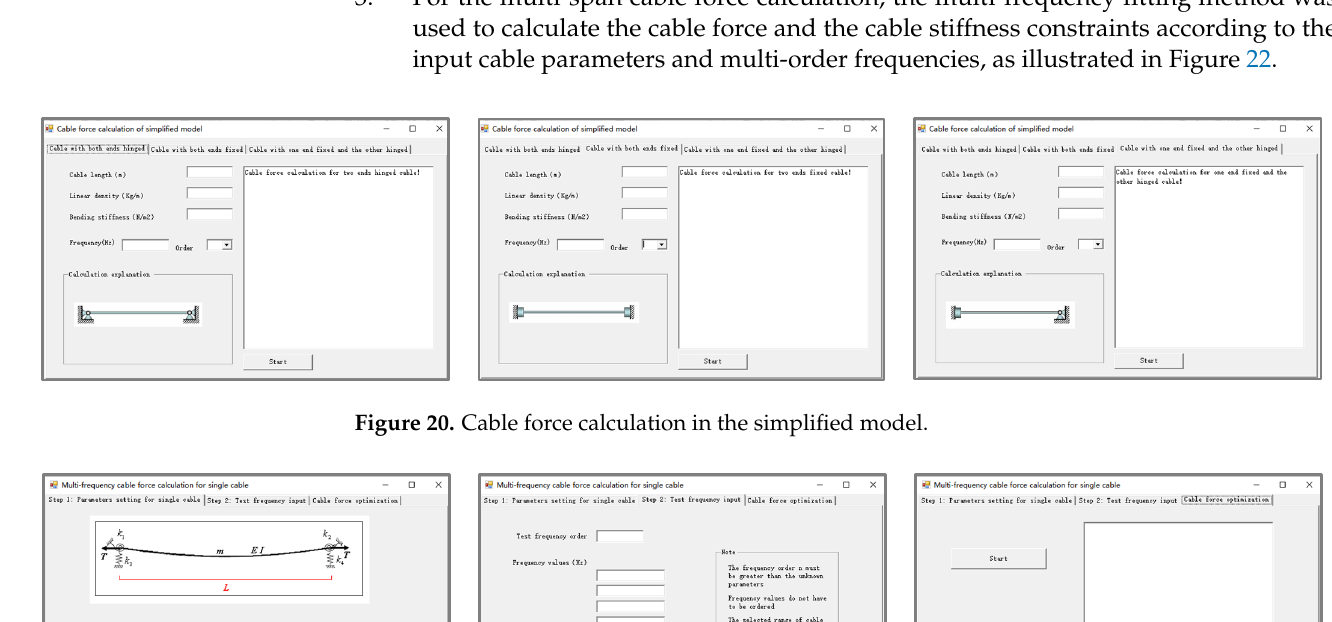
Figure 21. Single-cable force calculation with an arbitrary boundary.